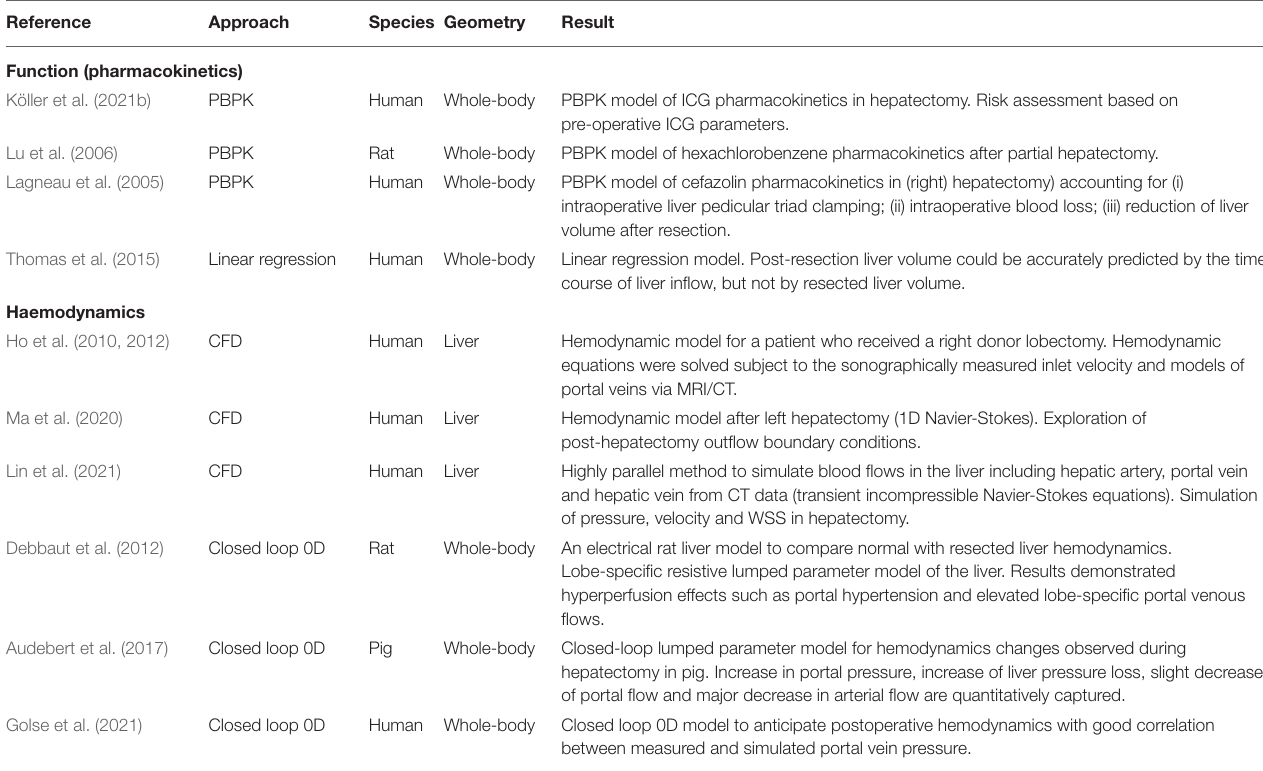
TABLE 9 | Selection of computational models on organ and body scale-related to